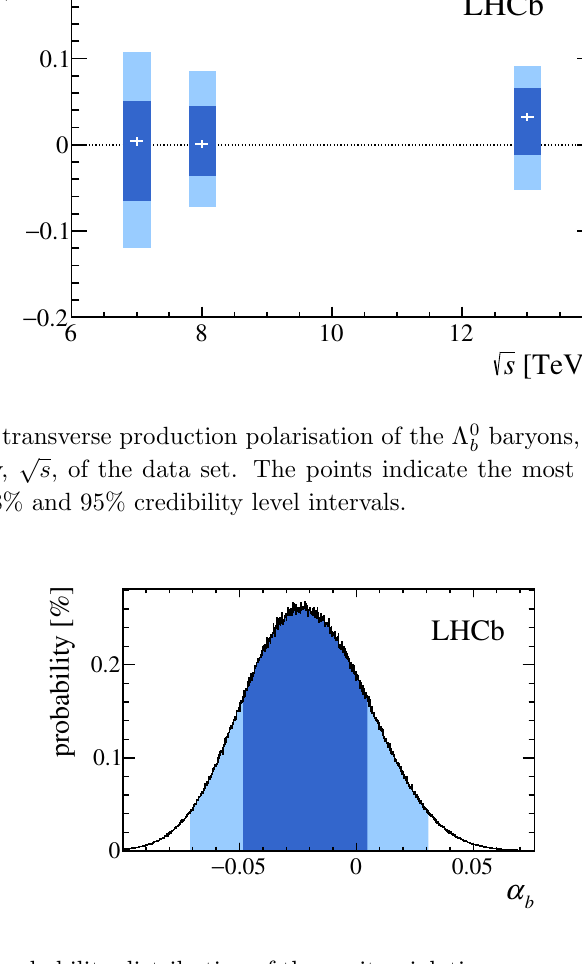
Figure 6 . Posterior probability distribution of the parity-violating asymmetry parameter, (cid:11) b . The shaded regions indicate the 68% and 95% credibility